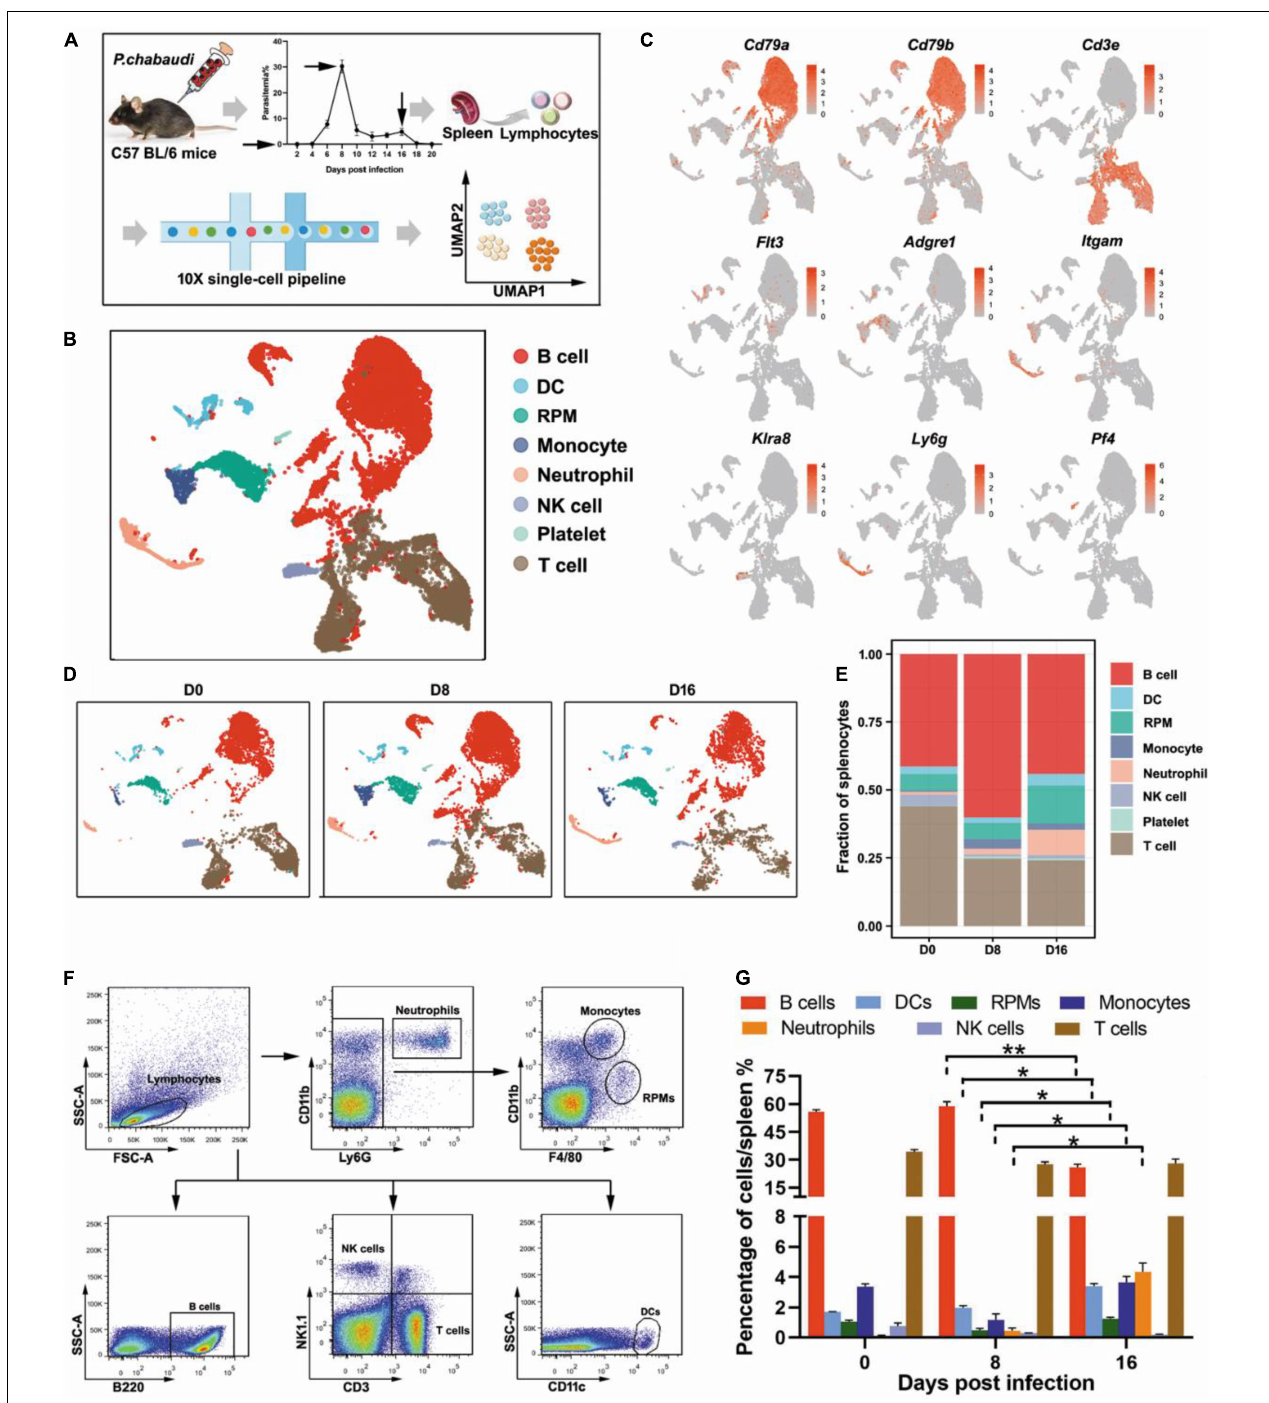
FIGURE 1 | Single-cell analysis revealed the dynamic changes of immune cells between the acute and recurrence stages of P. chabaudi infection. (A) Schematics of the experimental pipeline. Splenocytes from five mice were pooled together at days 0, 8, and 16 post-infection for 10 × Genomics scRNA-seq. The arrow indicates the day when mouse spleens were harvested. (B) Unsupervised clustering was performed on the UMAP to identify groups of cells with similar gene expression. (C) UMAP visualization showing the expression of canonical immune cell markers in each cluster of cells. (D) UMAP plot from (B) split by the three time points post-infection. (E) Fractions of immune cell populations relative to all splenocytes as the immune cell numbers change during the P. chabaudi infection. (F) Representative flow cytometry analysis of major immune cell populations at days 0, 8, and 16 post-infection. (G) Cellular composition of immune cells evaluated by flow cytometry as in (F) . The data are presented as mean ± SD based on three independent biological replicates. Plasma cells were included in the population of B cells, * P < 0.05; ** P < 0.01.